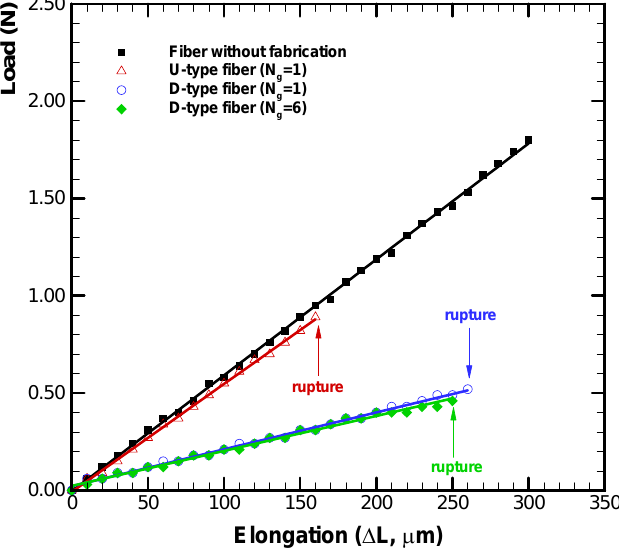
Figure 9. The load-elongation curve diagrams for optical fibers with different types of